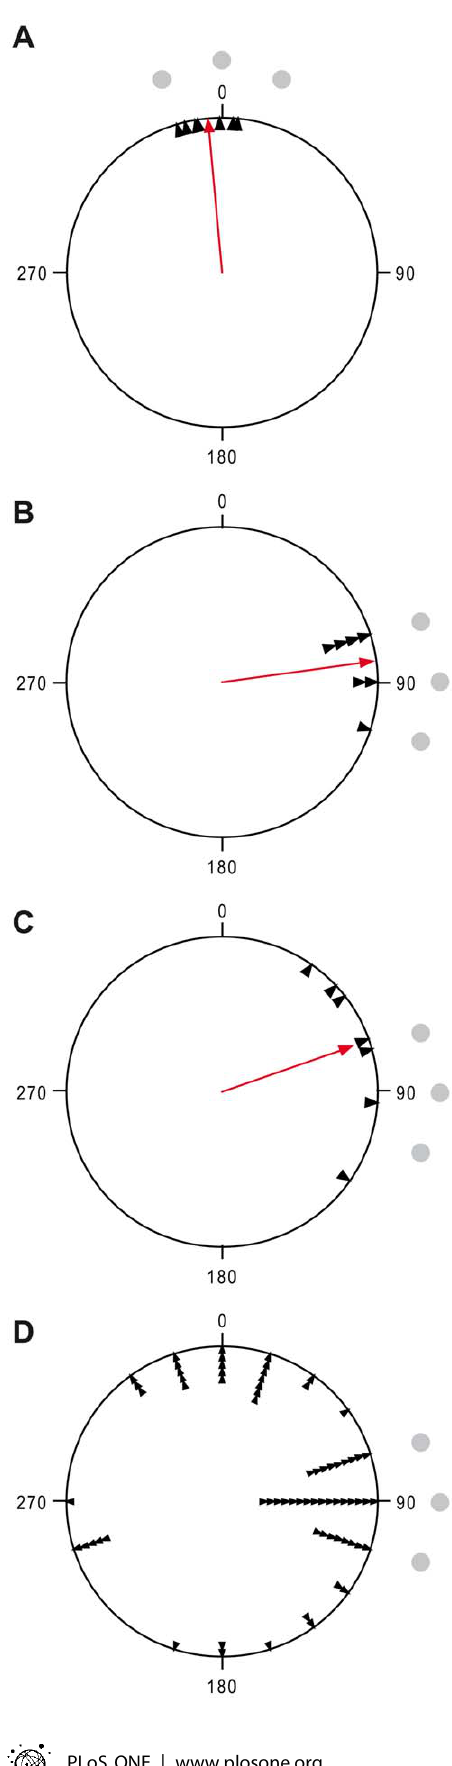
Figure 2. Results. Black dots represent baited positions. A) Small arrows represent individual means calculated from the last ten training trials B) Small arrows depict individual choice directions in the first test trial. C) Small arrows show individual means of choice directions calculated from the ten test trials. D) Small arrows point to individual single choices in all ten test trials. A–C) The centrally based arrow depicts the mean vector calculated from the individual